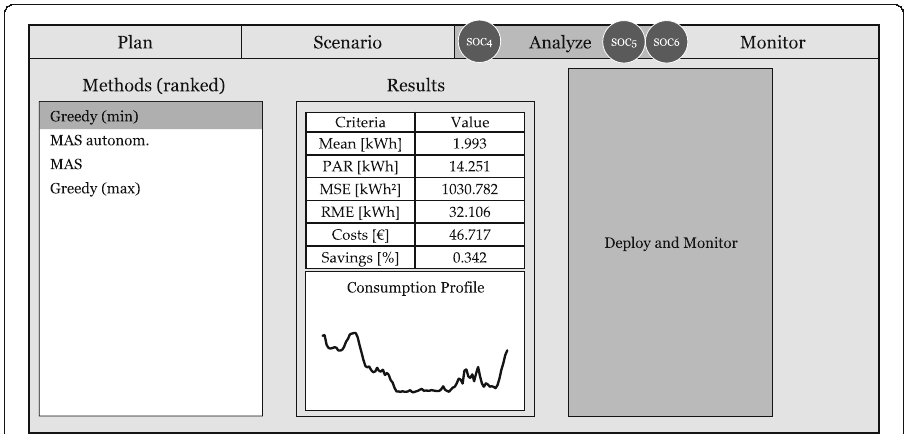
Fig. 9 Analysis of the results (schematic drawing)